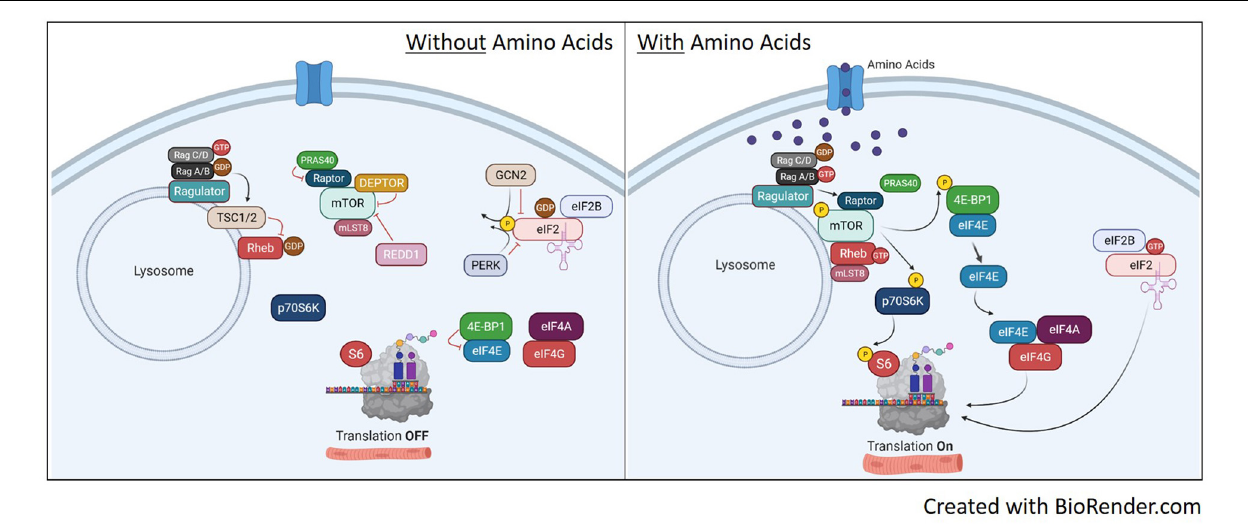
FIGURE 3 | Translation pathways with or without amino acid availability. Without amino acid availability (left image), the heterodimeric Rag protein is loaded with GTP on Rag C/D while Rag A/B has the GDP. This conformation localizes the TSC1/2 complex to the lysosome to prevent GDP-Rheb conversion to GTP and prevents the recruitment of mTORC1 to the lysosome. This renders both S6 and 4E-BP1 unphosphorylated, shutting off translation. In addition, the inactive mTORC1 with be further suppressed by inhibitors DEPTOR, REDD1 and PRAS. On the eIF2 pathway, the absence of amino acids maintains GCN2 and PERK activity, which phosphorylates eIF2, inhibiting guanine nucleotide exchange of eIF2 by eIF2B. With eIF2 bound to GDP, it will release from the ribosome and stop translation. Upon availability of amino acids (right image), RagA/B is now loaded with GTP as it maintains binding to ragulator. This initiates removal of TSC1/2 from the lysosome and Rag-induced recruitment of mTORC1 to the lysosome via raptor. Once at the lysosome, mTOR kinase activity is activated by GTP-bound Rheb and will phosphorylate p70S6K and 4E-BP1 to initiate translation. mTORC1 activation will also disassociate inhibitors DEPTOR and PRAS40. Once dissociated, DEPTROR is quickly degraded. In relation to eIF2, the availability of amino acids will inhibit GCN2 and PERK, reversing phosphorylation on eIF2 and allowing guanine nucleotide exchange of eIF2 back to GTP. This will bind the eIF2 complex to the 40S ribosomal subunit and initiate protein